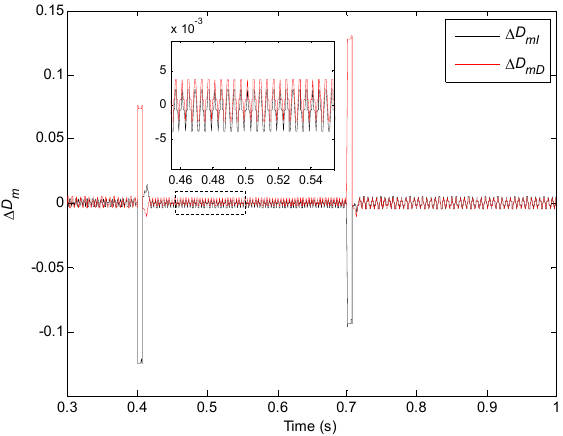
Figure 29. curves under two conditions. Figure 29. Curves under two